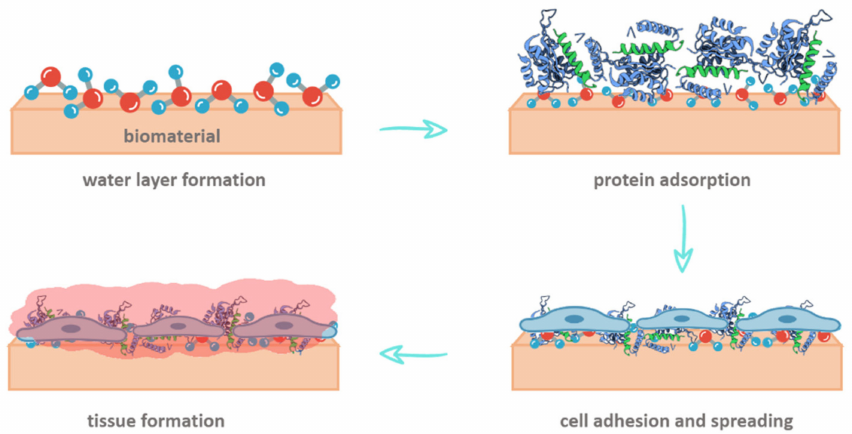
Figure 10. Schematic representation of the consecutive events on biomaterial surface subsequently to implantation